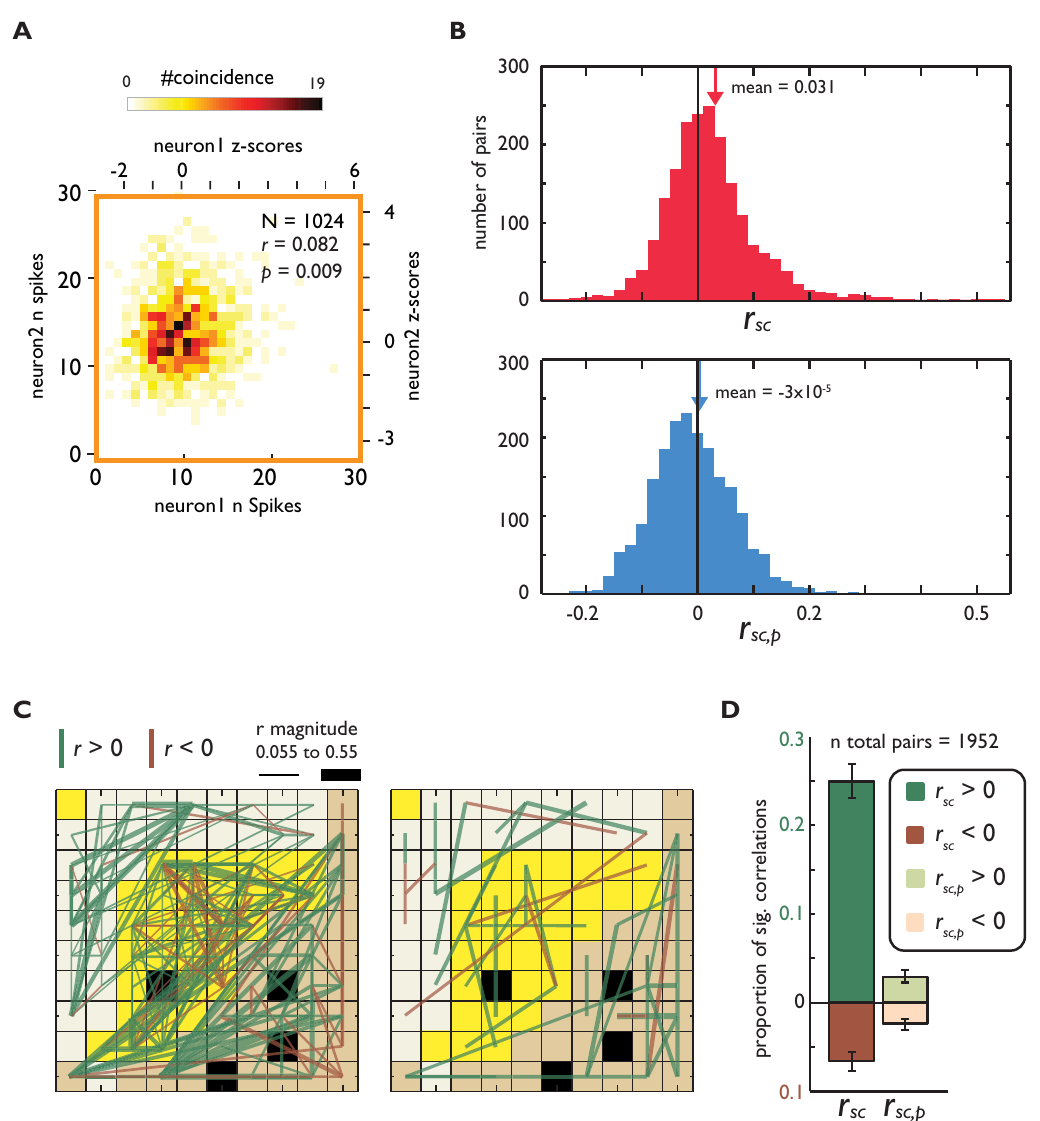
Figure 3. Spike count correlation ( r sc ) example and population statistics. A ) Example correlation between the responses of two neurons. The left x-axis and bottom y-axis represent the absolute number of spikes fired by each neuron in simultaneously recorded trials. The right x-axis and top y-axis show the z-transformed data. The color scale represents coincidences of spike counts. B ) Histograms displaying the distribution of Fisher- transformed spike count correlations in the recorded data (red) and in the Poisson simulated neurons (blue). The arrows indicate the means of the distributions. C ) Distribution of correlations and neurons on the MEA from animal ‘F’. Each square represents an electrode, and each line represents a correlation between two neurons recorded on the constituent electrodes. The thickness of a line is proportional to the magnitude of the correlation (from 0.055 to 0.55) and the color represents the sign (brown=negative, green=positive). The panel on the left illustrates significant correlations from the recorded data ( r sc ), while the right panel illustrates significant correlations occurring by chance ( r sc,p ). D ) The proportion of significant positive and negative correlations for the data shown in C . Observe that the ordinate of the negative correlations is inverted for a better comparison of the correlation